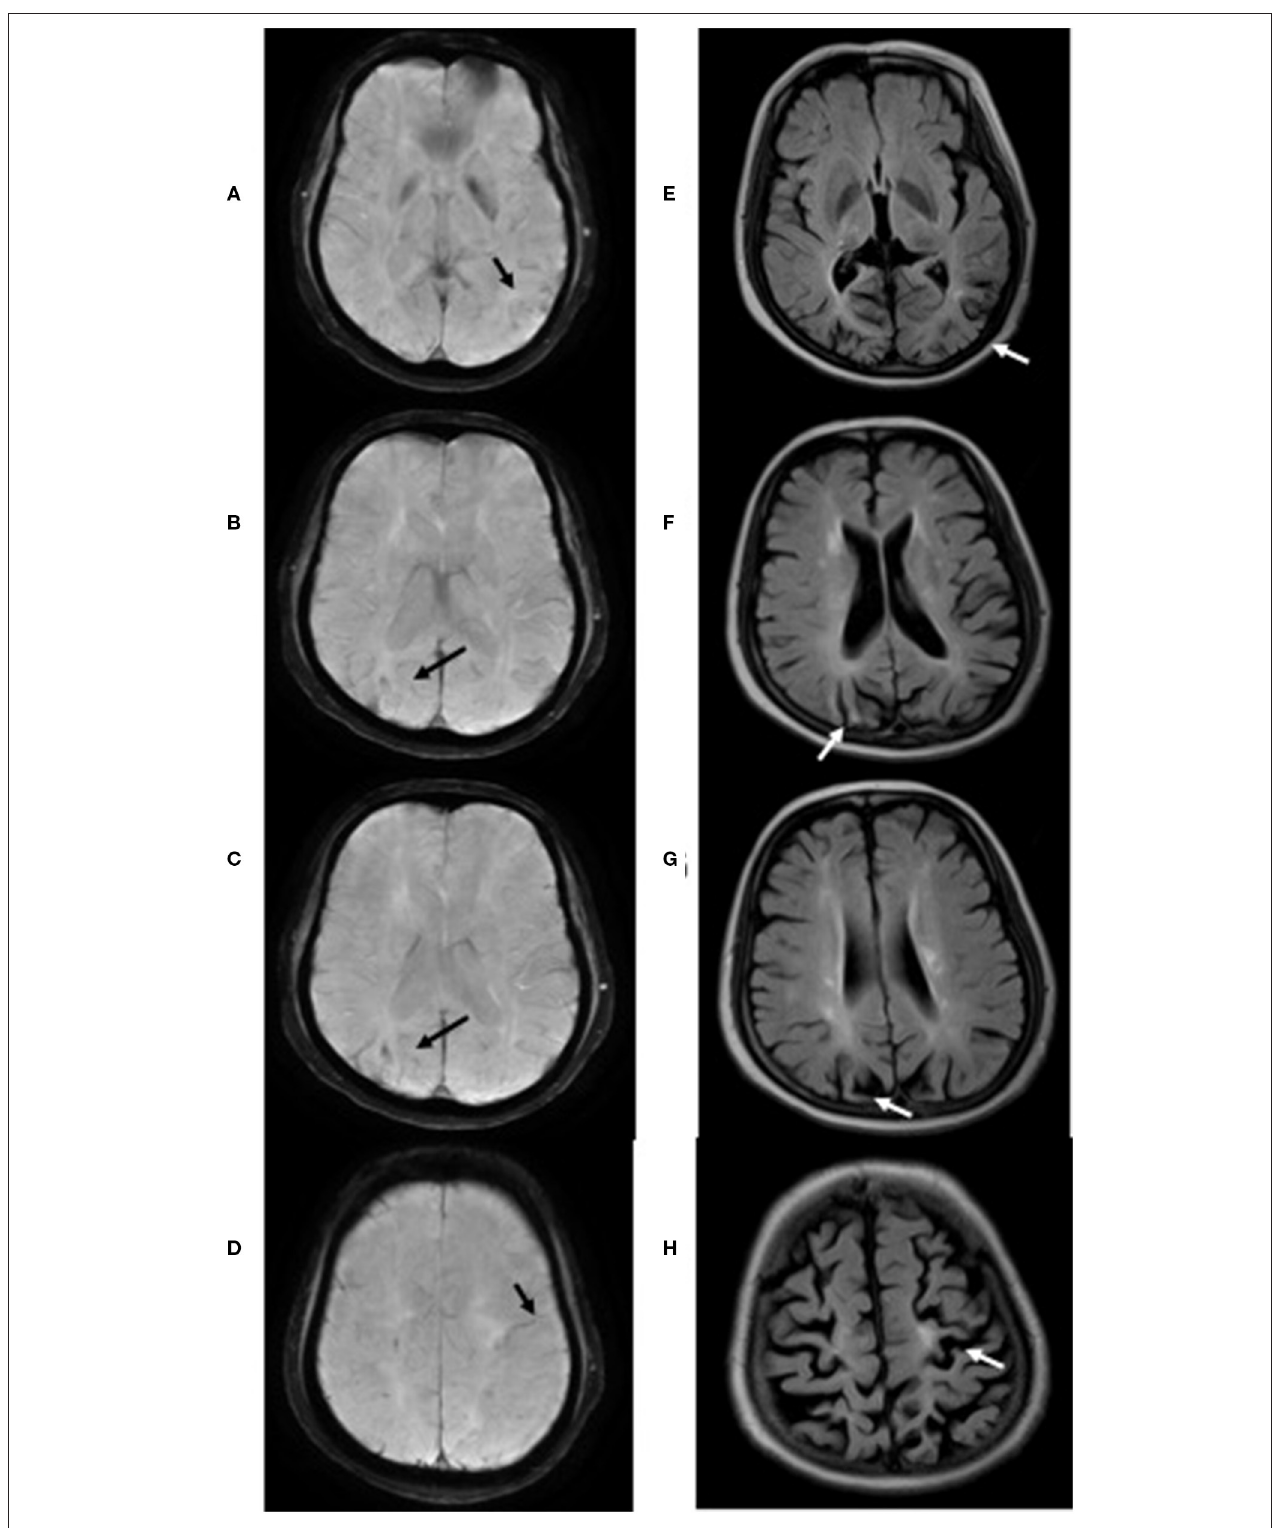
FIGURE 1 | T2 * sequences of case 3 showed cortical superficial siderosis (black arrow) mainly involving the left temporal lobe (A) , right parieto-occipital region (B–D) and left central (D) . Significant cerebral atrophy (white arrow) was observed in the regions above-mentioned on Flair sequences (E–H) .